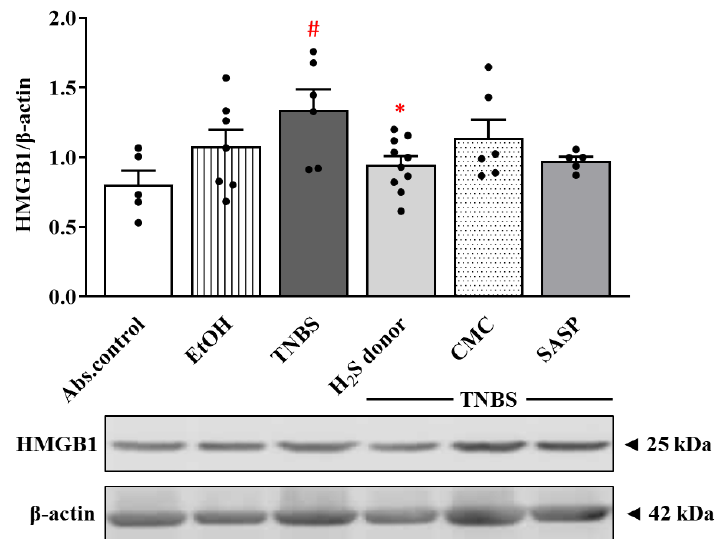
Figure 5. Alterations of the expression of HMGB1 in the treated groups. Absolute control (no treat- ment); EtOH (50% ethanol, the solvent of TNBS); TNBS (2,4,6-trinitrobenzenesulfonic acid enema); H 2 S donor (TNBS + 18.75 μM/kg/day Lawesson’s reagent); CMC (TNBS + 0.5% carboxymethylcellu- lose, the vehicle of Lawesson’s reagent); SASP (TNBS + 50 mg/kg/day sulfasalazine, as a positive control). Results are presented as mean + S.E.M.; n = 5 – 10/group; one-way ANOVA, Holm – Sidak post hoc test, # p < 0.05 absolute control vs. TNBS; * p < 0.05 TNBS vs. TNBS + H 2 S donor treatment.